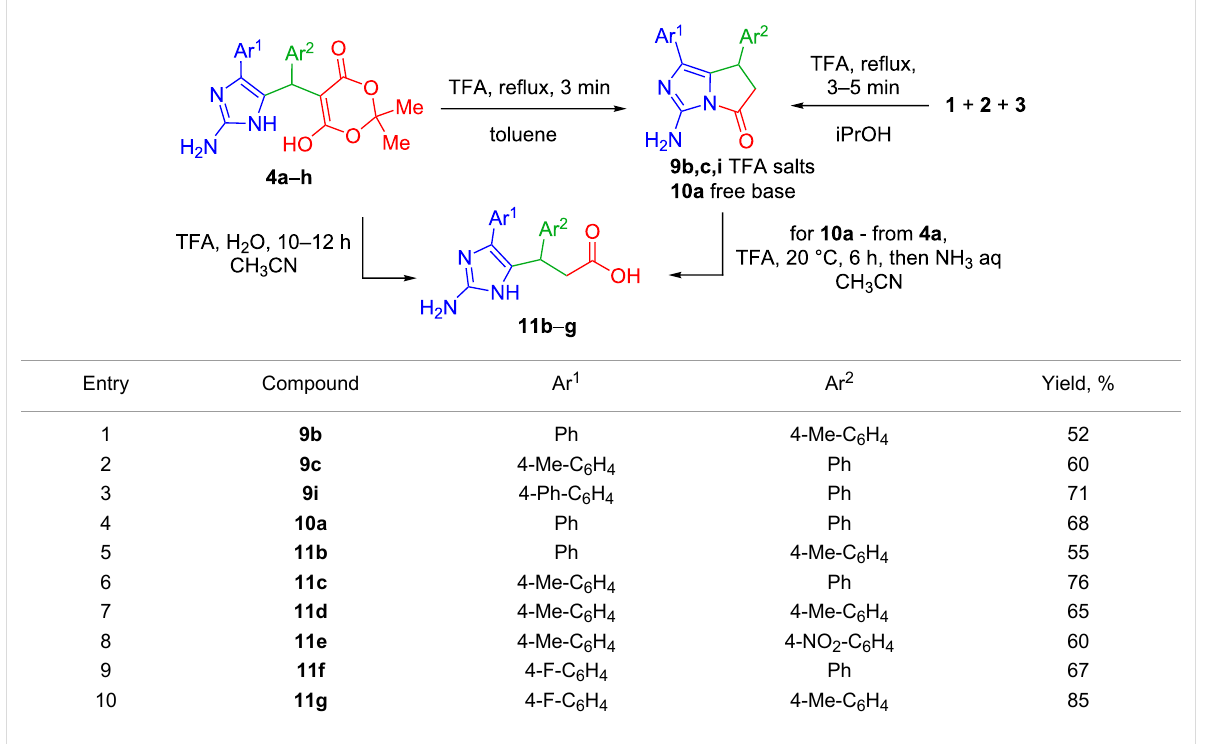
Table 2: Synthesis of compounds 9b , c , i , 10a , 11b–g .